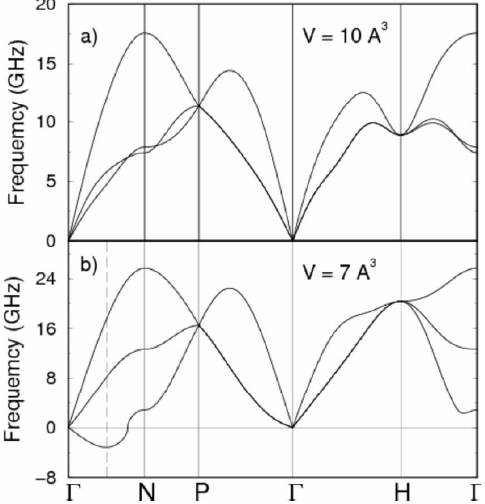
Figure 1. Phonon spectra of the bcc-Mo at ( a ) V = 10 Å 3 /atom) and ( b ) V = 7 Å 3 /atom), i.e., around 350 GPa and 1000 GPa, respectively. Imaginary frequences, shown for simplicity as negative numbers, that appear in the bcc-Mo phonon spectrum at 1000 GPa indicate dynamical